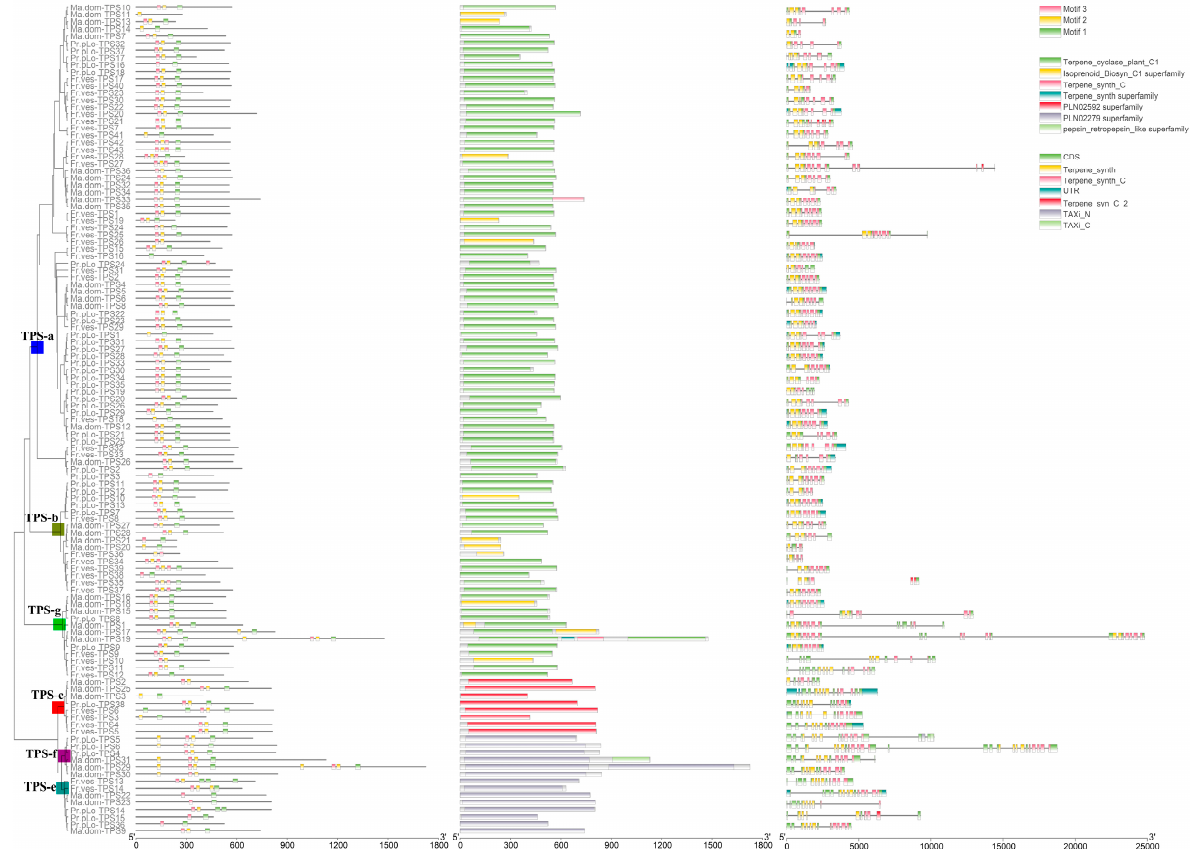
Figure 1. Phylogenetic relationship and distribution of motif/domain of TPSs in three Rosaceae species ( P. persica , M. domestica , F. vesca ). The phylogenetic tree is shown on the left panel, while conserved motifs, conserved domains, and Pfam domains are shown on the right three panels. The phylogenetic tree from full-length amino acid sequences was constructed using the MEGA with maximum likelihood (ML) method. The conserved motifs were assessed using the online MEME software. The conserved domain was annotated based on the conserved domain database in NCBI, whereas the gene structure and domains were annotated by using the PfamScan tool. The conserved motifs and domains are shaded in different colors. The root nodes of TPS-a, TPS-g, TPS-b, TPS-c, TPS-e, and TPS-f clades are indicated by blue, green, yellow-green, red, benzo, and purple, respec- tively.